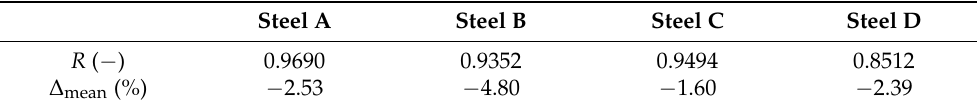
Table 5. Accuracy of ε p values predicted according to Equation